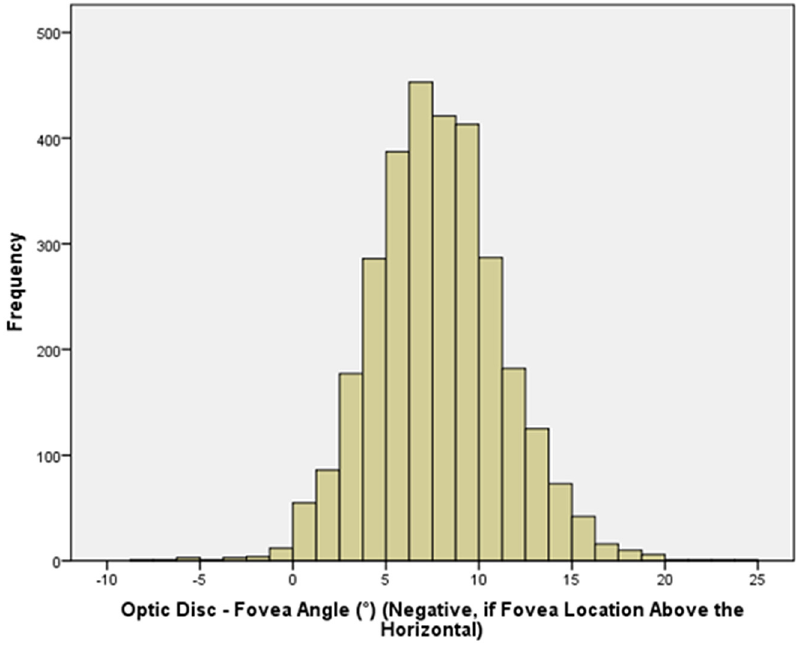
Fig 1. Histogram Showing the Distribution of the Optic Disc — Fovea Angle in the Beijing Eye Study 2011.